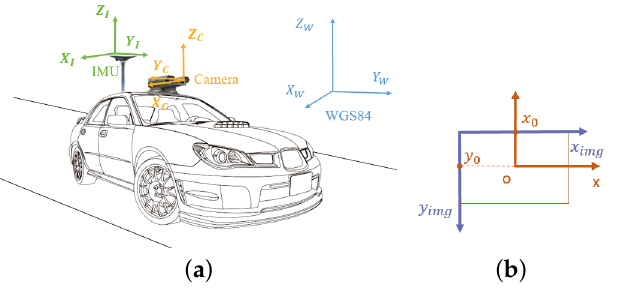
Figure 14. The 3D points are mapped onto the MMS image plane. ( a ) The relationship between the geodetic, IMU, and camera coordinate systems. ( b ) From the camera coordinate system to the MMS image plane, we finally obtain the column and row of the mapped pixel.